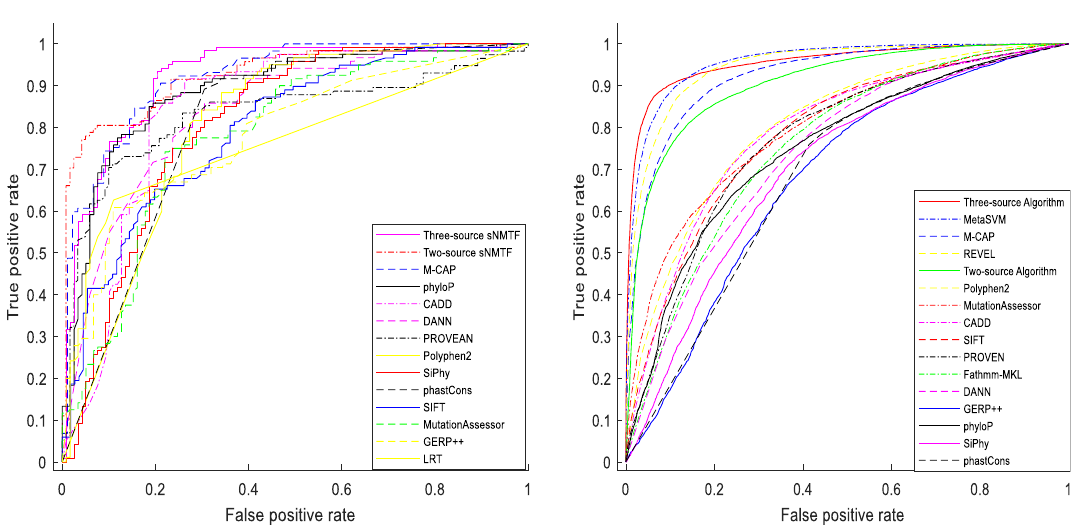
Figure 4. ROC curves of different methods at testing dataset I (right) and testing dataset II (left). The figure is created using MATLAB version 7.0.1 (Math Software Co., Math Works,